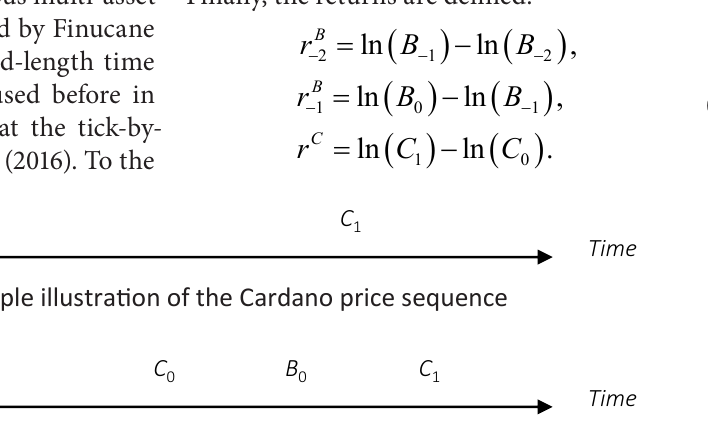
Figure 2. The asynchronous integration of Bitcoin and Cardano